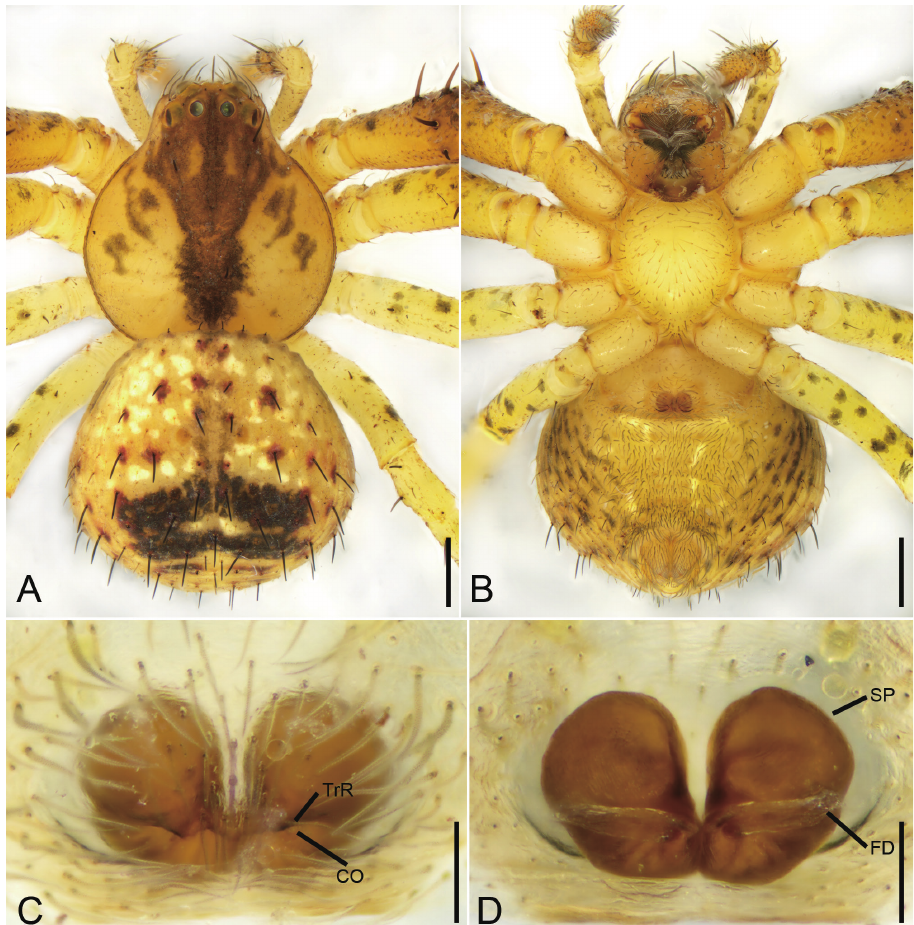
Figure 11. Pharta lingxiufengica sp. nov., female holotype. A habitus, dorsal view B same, ventral view C epigyne, ventral view D same, dorsal view. Abbreviations: CO – copulatory opening, FD – fertilisa- tion duct, SP – spermatheca, TrR – transverse ridge of copulatory openings. Scale bars: 0.5 mm ( A, B ), 0.1 mm ( C, D